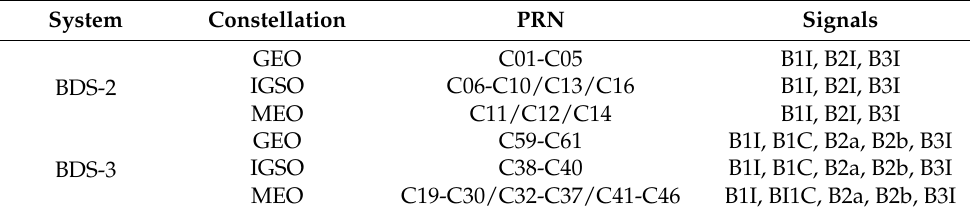
Table 1. Satellite signal and orbit types for